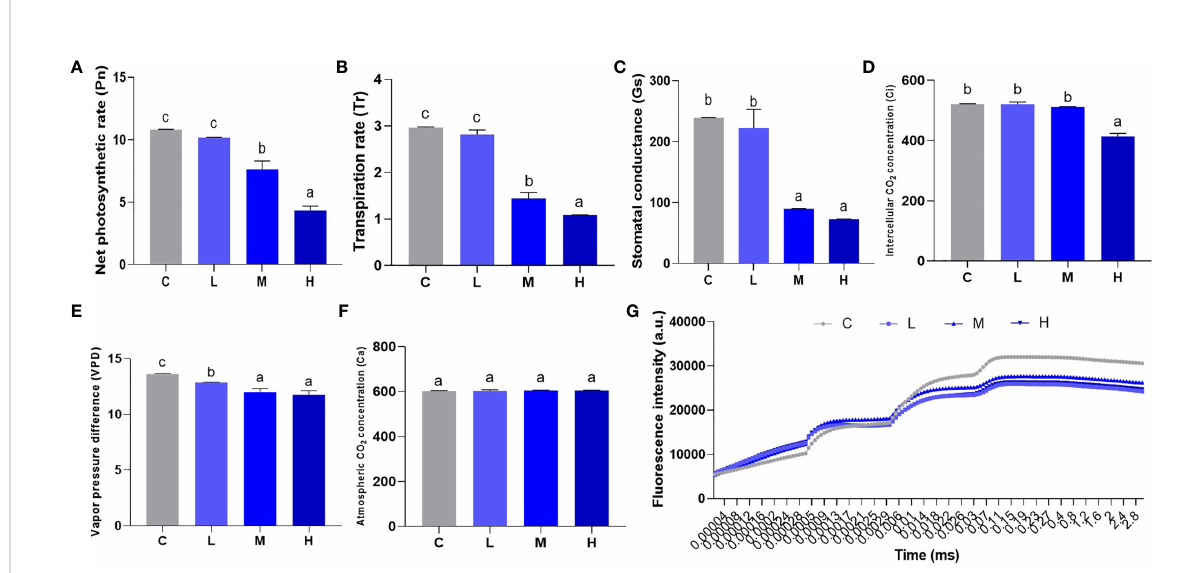
FIGURE 4 Effect of Pb stress on the dose-dependent effect of photosynthesis of pakchoi. (A) The net photosynthetic rate (Pn) in pakchoi leaves (44 d) (n=3). (B) The transpiration rate (Tr) in pakchoi leaves (44 d) (n=3). (C) The stomatal conductance (Gs) in pakchoi leaves (44 d) (n=3). (D) The intercellular CO2 concentration (Ci) in pakchoi leaves (44 d) (n=3). (E) The vapor pressure difference (VPD) in pakchoi leaves (44 d) (n=3). (F) The atmospheric CO 2 concentration (Ca) in pakchoi leaves (44 d) (n=3). (G) Over time, the fl uorescence intensity (a. u.) of pakchoi in pakchoi leaves (44 d) (n=3). The same letter indicates no signi fi cant difference (P > 0.05); completely different letter indicates signi fi cant difference (P <